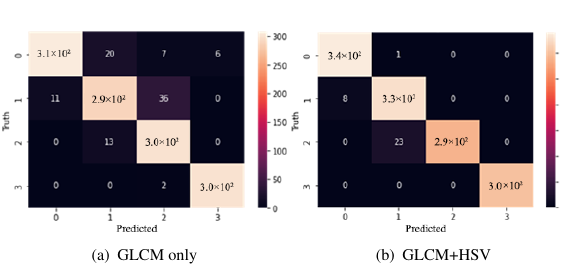
Fig. 9 Confusion matrices of LightGBM classifier.